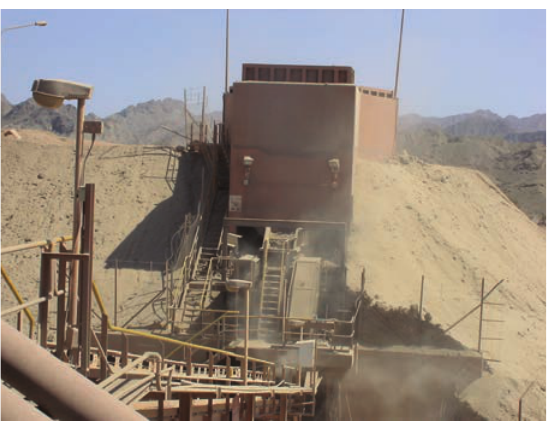
Figure 2. Photograph shows the open pit.